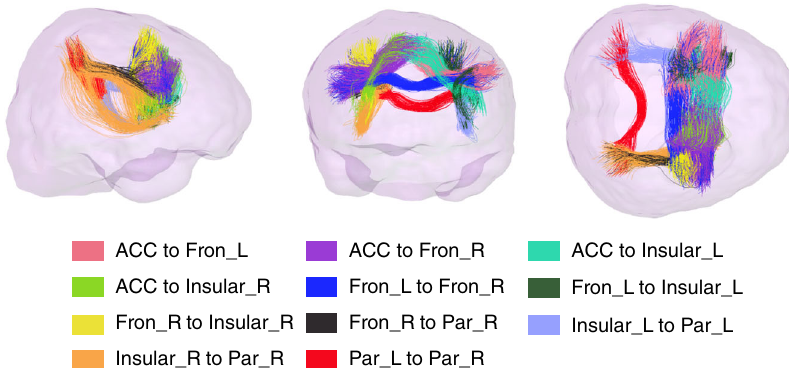
Fig. 2 Eleven highly reproducible tracts. These tracts are displayed in different colors in a single subject ’ s native coordinates